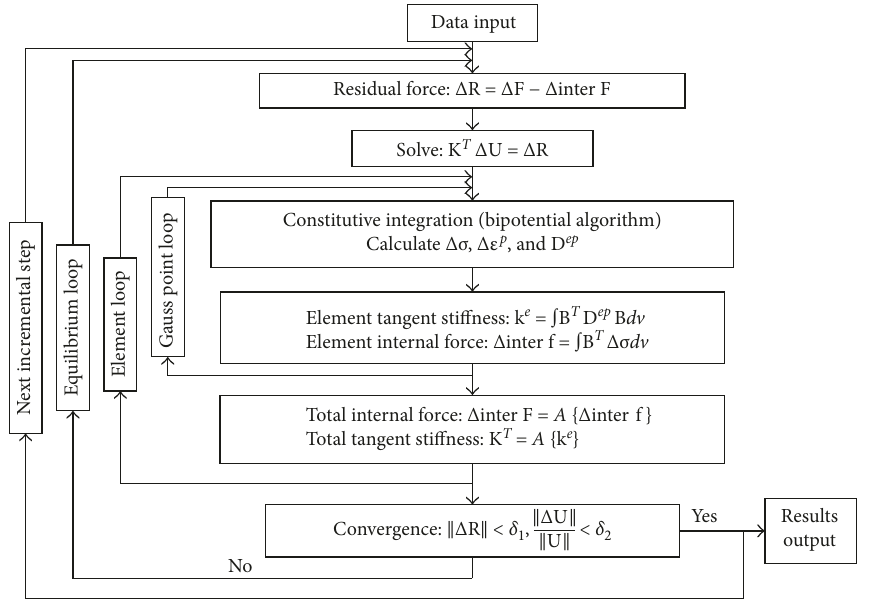
Figure 3: Process of the Newton–Raphson strategy.